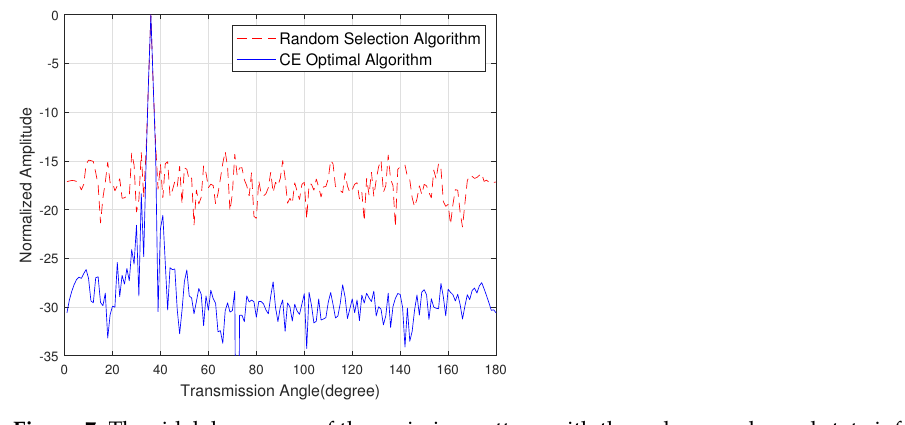
Figure 7. The sidelobe energy of the emission pattern with the unknown channel state information of the